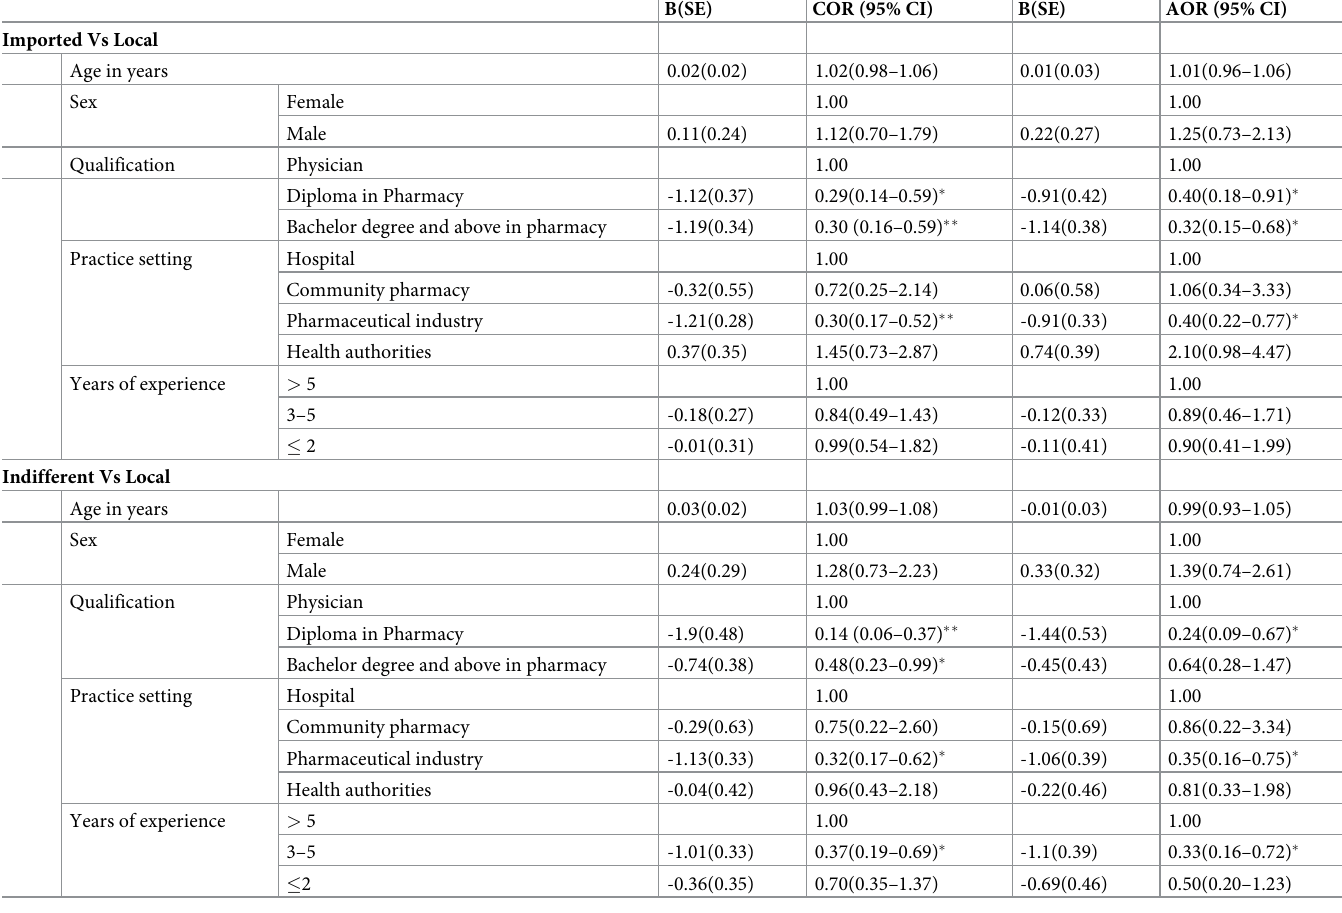
Table 3. Multinomial logistic regression analysis of factors associated with preference on sources of medicines among health professionals practicing in Addis Ababa, Ethiopia.